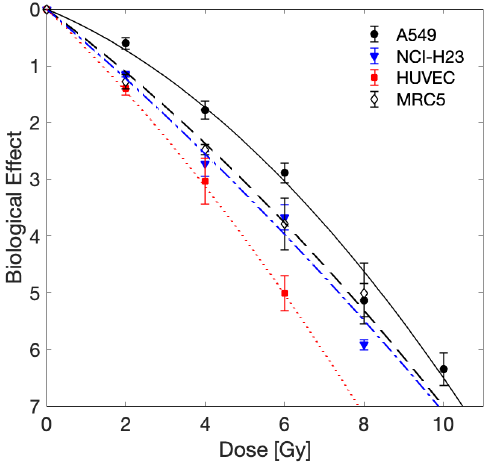
Figure 2. Experimentally measured biological effect of BB irradiation. Mean values and standard deviation of three independent experiments are shown. Data were fit by the LQ-model as indicated by lines (solid: A549, dashed: NCI-H23, dashed-dotted: MRC5, dotted: HUVEC); fit parameters obtained are shown in Table